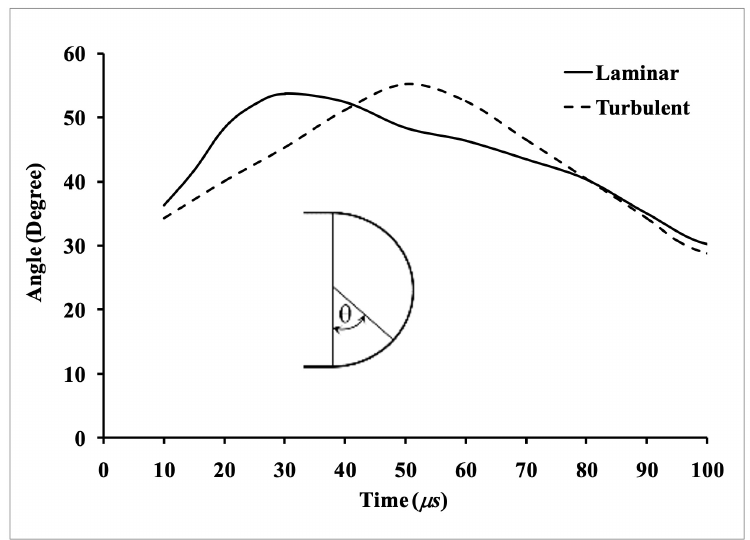
Fig. 10. Separation point location of shock wave diffraction around curved splitter for laminar and turbulent